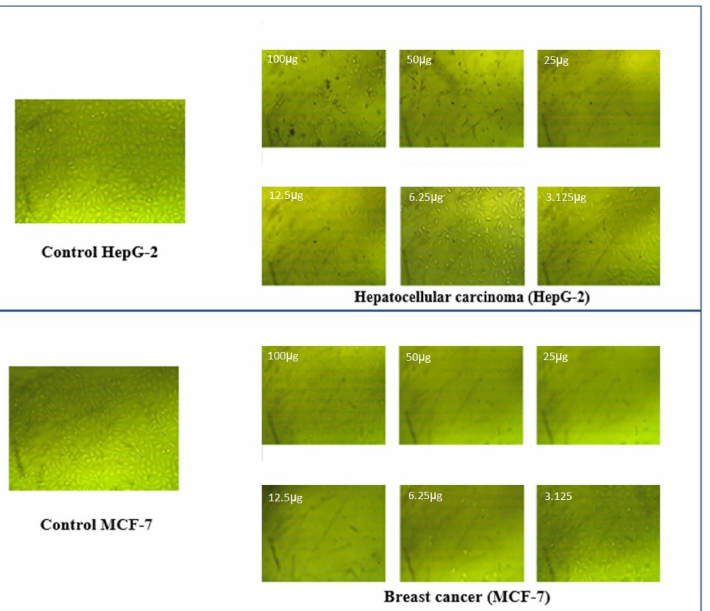
Figure 10. Morphology images of hepatocellular carcinoma (HepG-2) and breast cancer (MCF-7) treatment by [VO(PNZ) 2 ]SO 4 · 2H 2